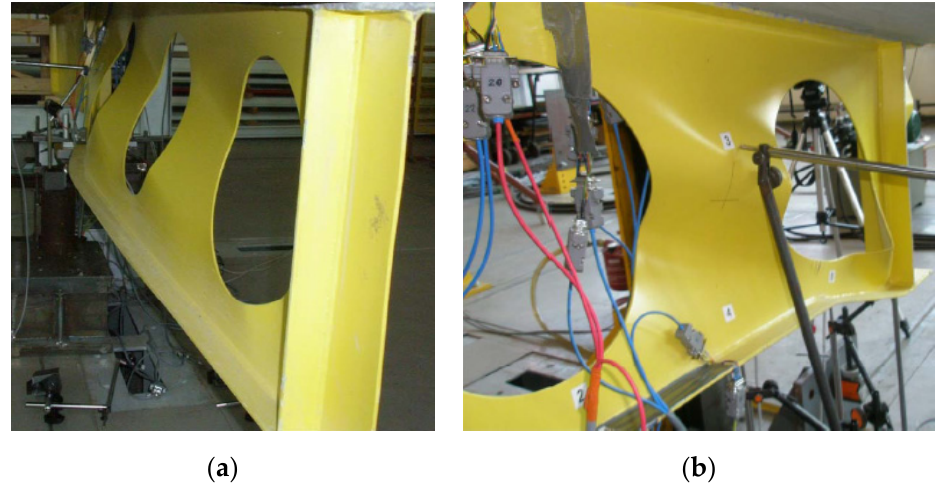
Figure 16. Experimental tests by Salah [58] and Gizejowski and Salah [59]: ( a ) Lateral distortional mode; ( b ) Torsional-distortional mode.